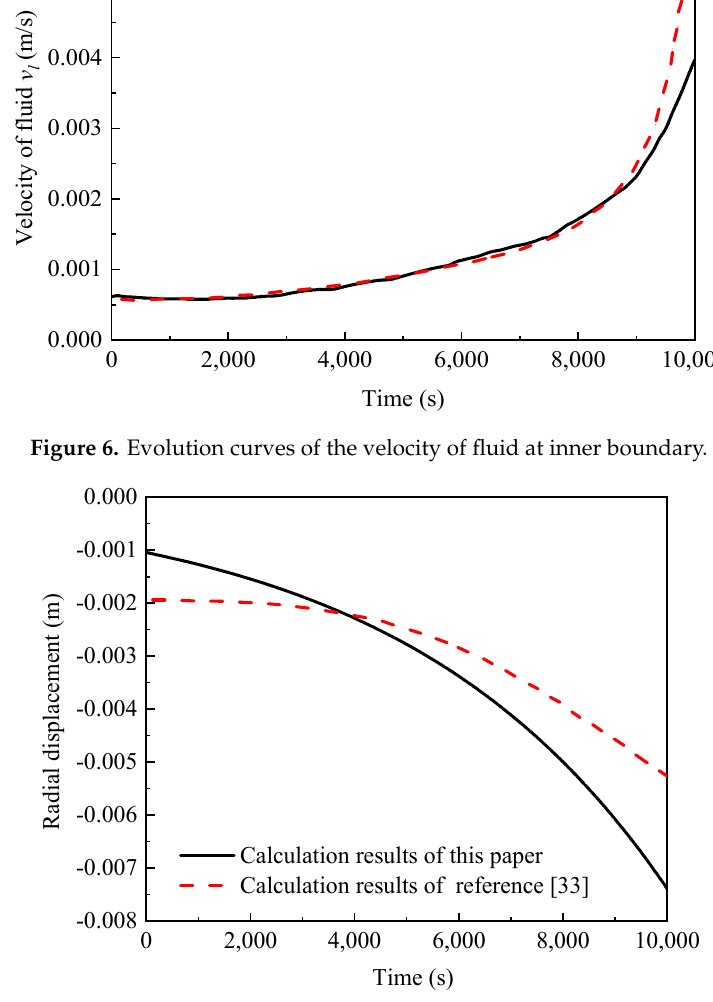
Figure 7. Evolution curves of the radial displacement at inner boundary.